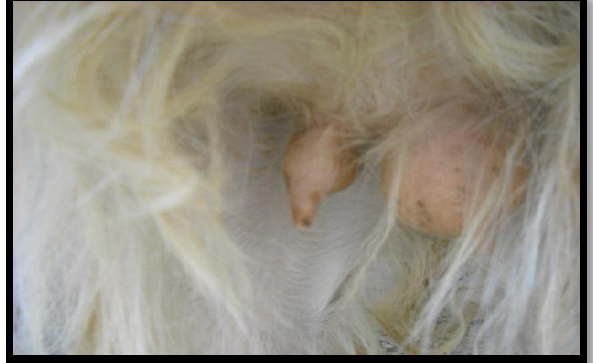
Figure (2): The right infected half of goat showed a decrease in the size when compared with non- in-fected left udder halves (control group after challenge at the 35 days of experiment).